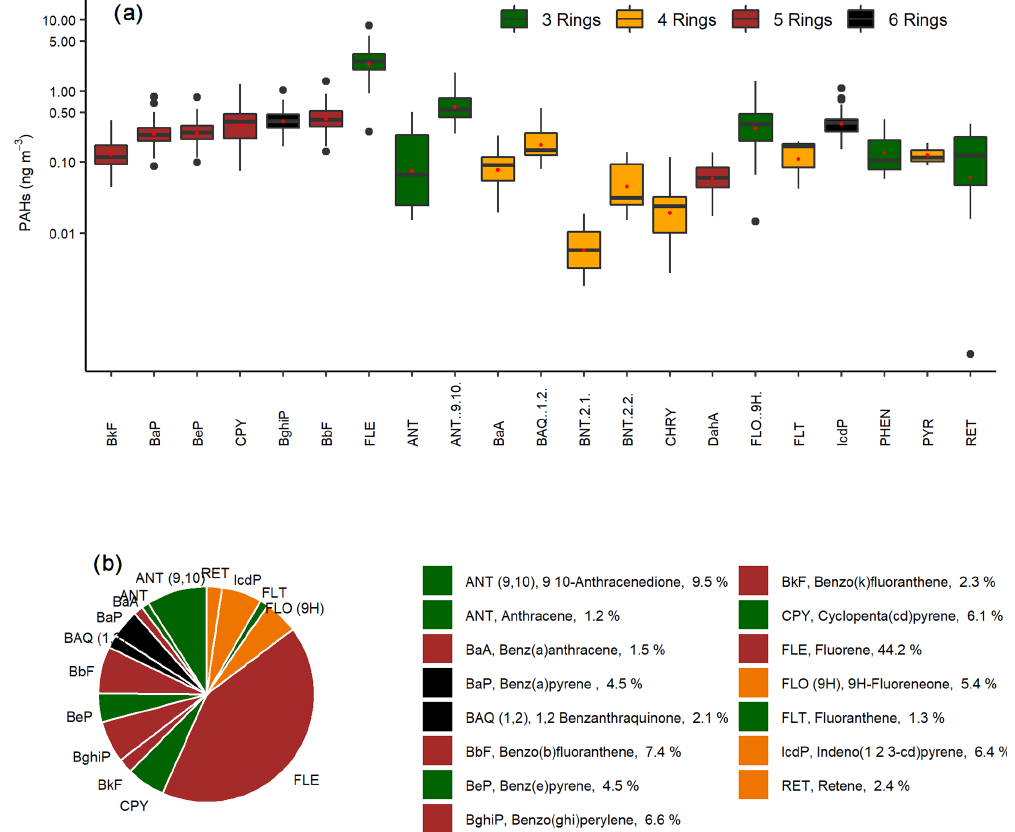
Figure 4. The abundance of PAHs measured in PM 2 . 5 samples collected in the CRV, represented by colors according to the number of rings of each PAH, indicated in green (three rings), yellow (four rings), brown (five rings), and black (six rings). (a) Box plot of concentrations in nanogram per cubic meter (ngm − 3 ), and the red dots represent the mean concentrations of each PAH. (b) Pie chart of the relative abundance of PAHs in PM 2 . 5